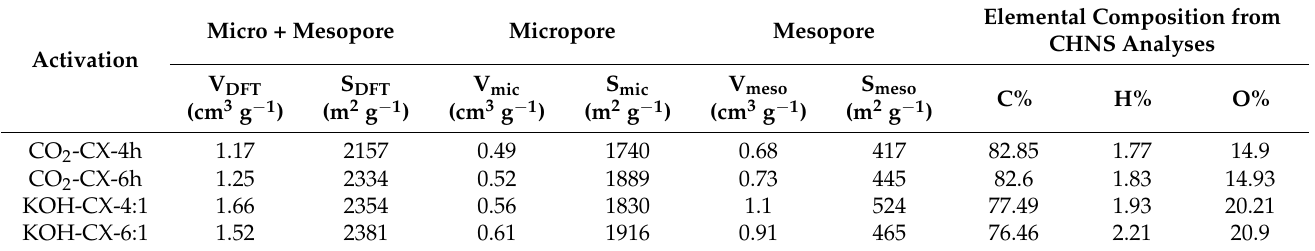
Table 4. Effect of type of activation on porous texture and elemental compositions of